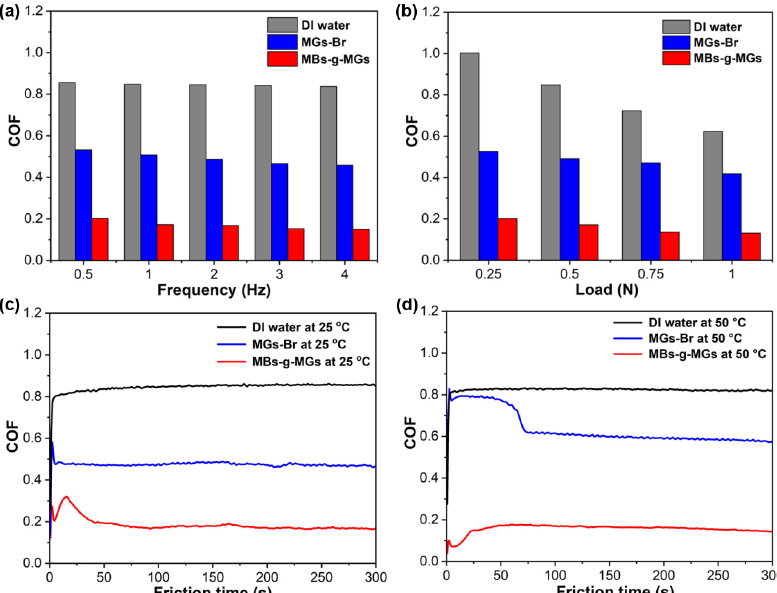
Fig. 6 (a) COFs of MGs-Br and MBs-g-MGs as a function of frequency with pure water as the reference (temperature: 25 °C, normal load: 0.5 N, and amplitude: 2.0 mm). (b) COFs of MGs-Br and MBs-g-MGs as a function of normal load with pure water as the reference (temperature: 25 °C, frequency: 1.0 Hz, and amplitude: 2.0 mm). Friction curves of MGs-Br and MBs-g-MGs at (c) 25 °C and (d) 50 °C with pure water as the reference (normal load: 0.5 N, frequency: 1.0 Hz, and amplitude: 2.0